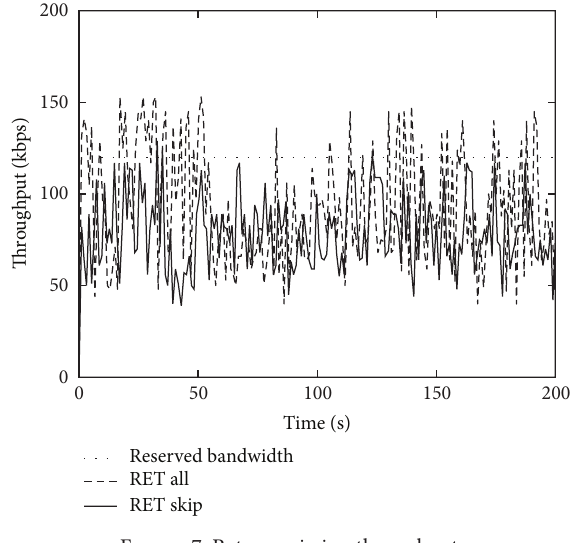
Figure 7: Retransmission